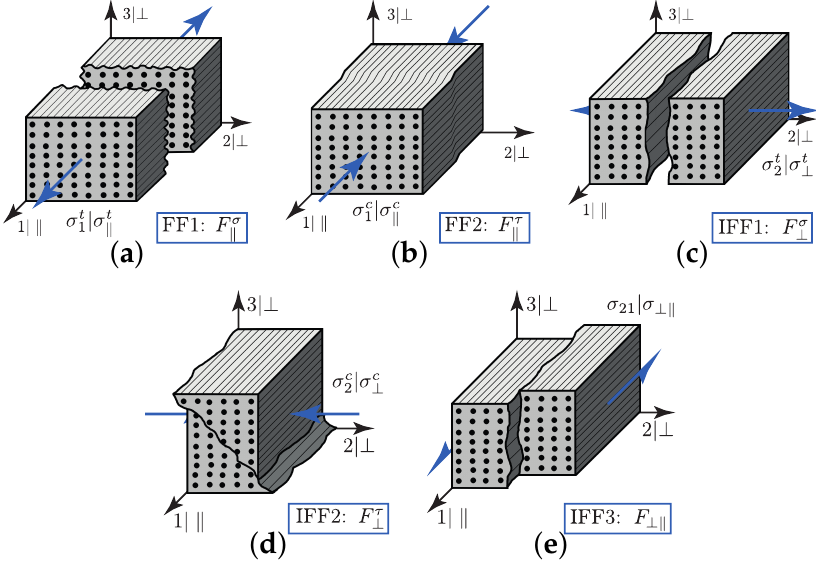
Figure 16. Illustration of failure modes (FMs) of a brittle transversely isotropic material: ( a ) fibre failure parallel tension (FF1: F σ ), ( b ) fibre failure parallel compression (FF2: F τ (cid:107) transverse tension (IFF1: F σ ⊥ ), ( d ) inter-fibre failure transverse compression (IFF2: F τ ⊥ ) and ( e ) inter fibre failure shear (IFF3: F ⊥(cid:107) )